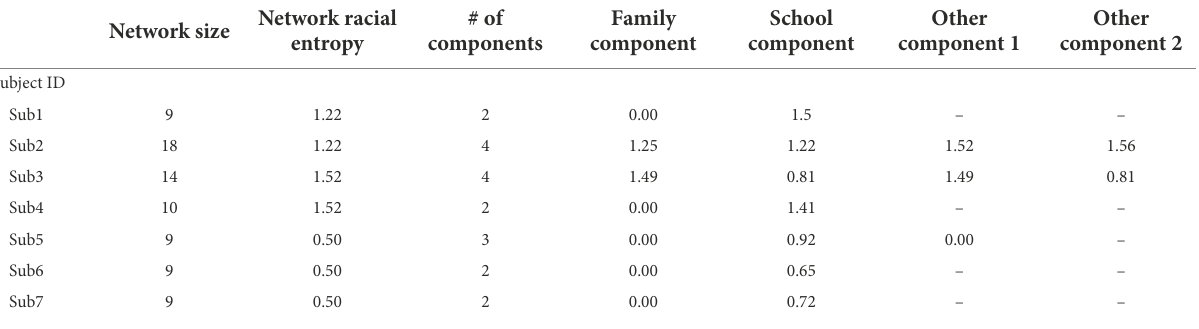
TABLE 3 Example social network